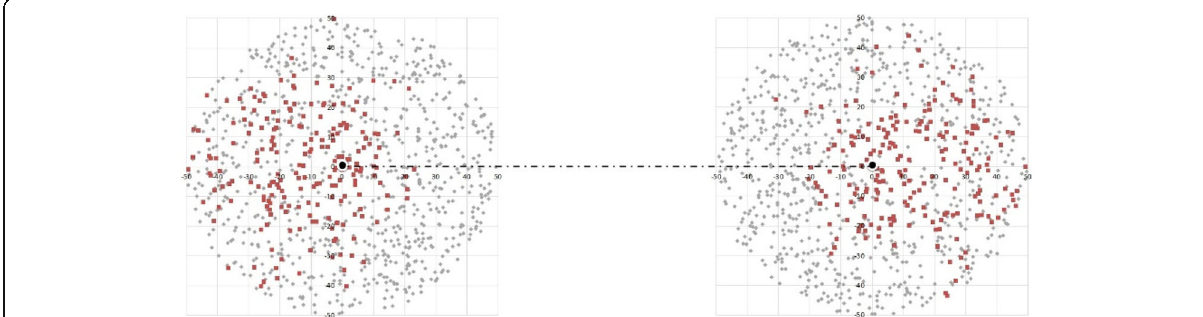
Fig. 6 The distribution of all shippers/consignees points after simulation